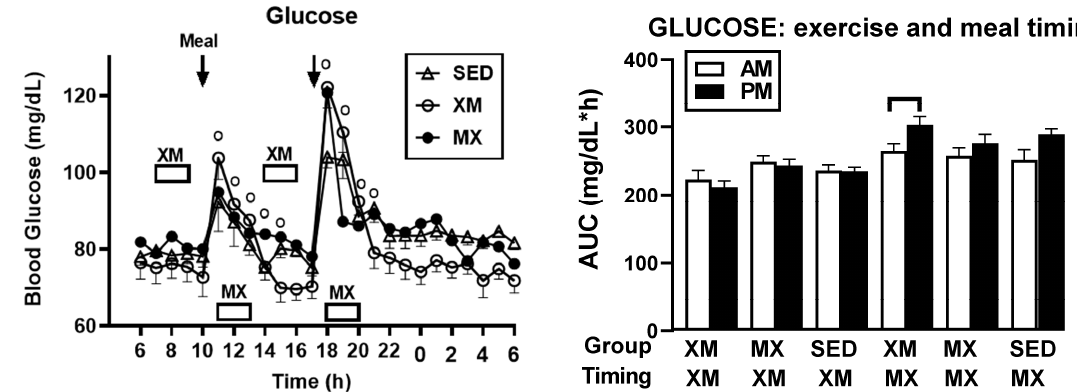
Figure 5. Exercise- and meal-timing effects on glucose concentrations ( left panel) and AUCs ( right panel). Circle superscripts identify time slices when group differences were significantly different ( left panel). Timing analysis of group AUCs (treatment indicated in the top abscissa row) is presented for time periods assigned to XM and MX exercise (indicated in the bottom abscissa row). Bracket ( right panel) identifies asignificant within-group difference in postprandial timing of XM trial. XM = exercise before meals, MX = exercise after meals, SED = sedentary group.